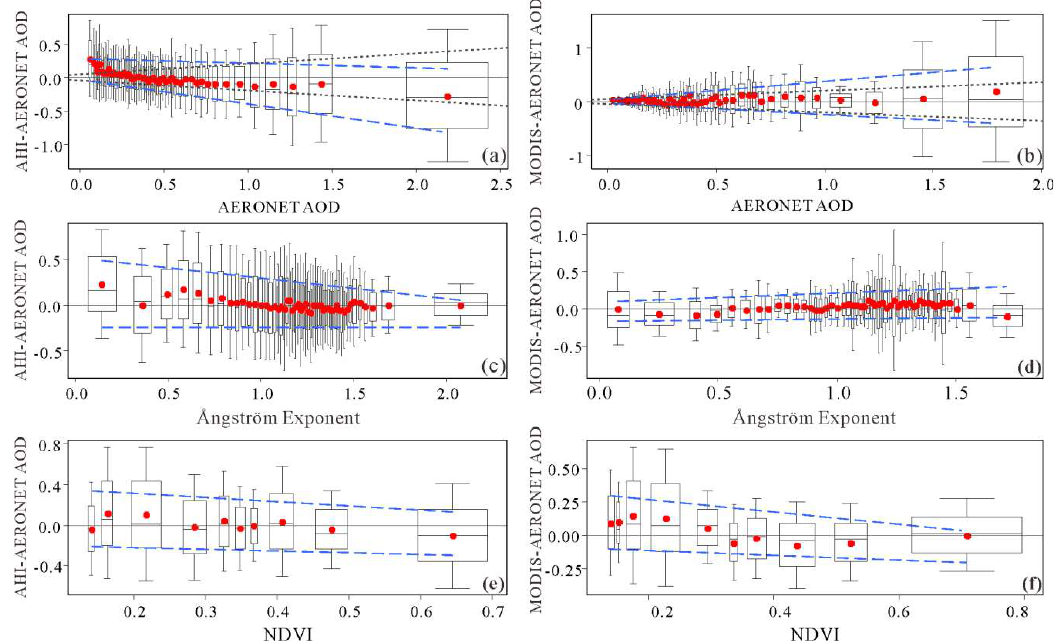
Figure 9. Biases in satellite-based AOD as functions of AERONET AOD values at 500 nm ( a , b ), Ångström Exponent between 440–675 nm ( c , d ) and NDVI ( e , f ).